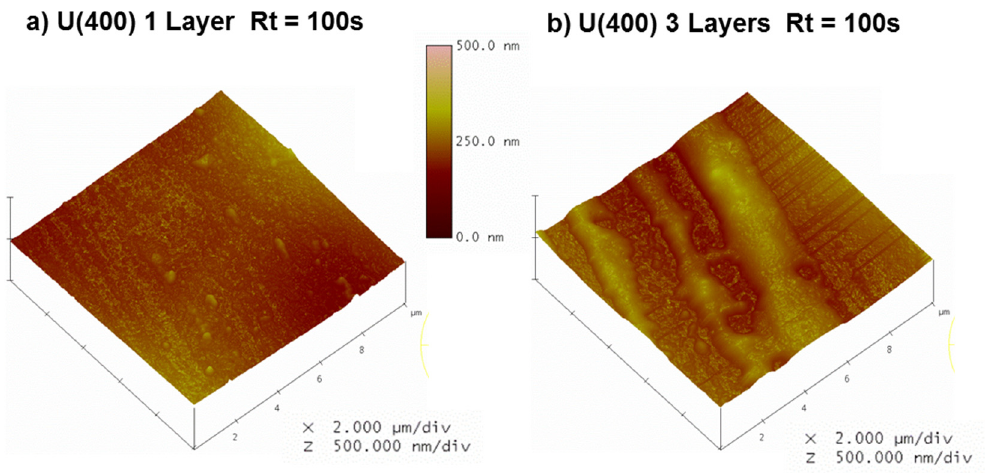
Figure 4. AFM topographic images for HDGS samples coated by: ( a ) one dip step (one layer) and ( b ) three dip steps (three layers) with cures between each deposition.